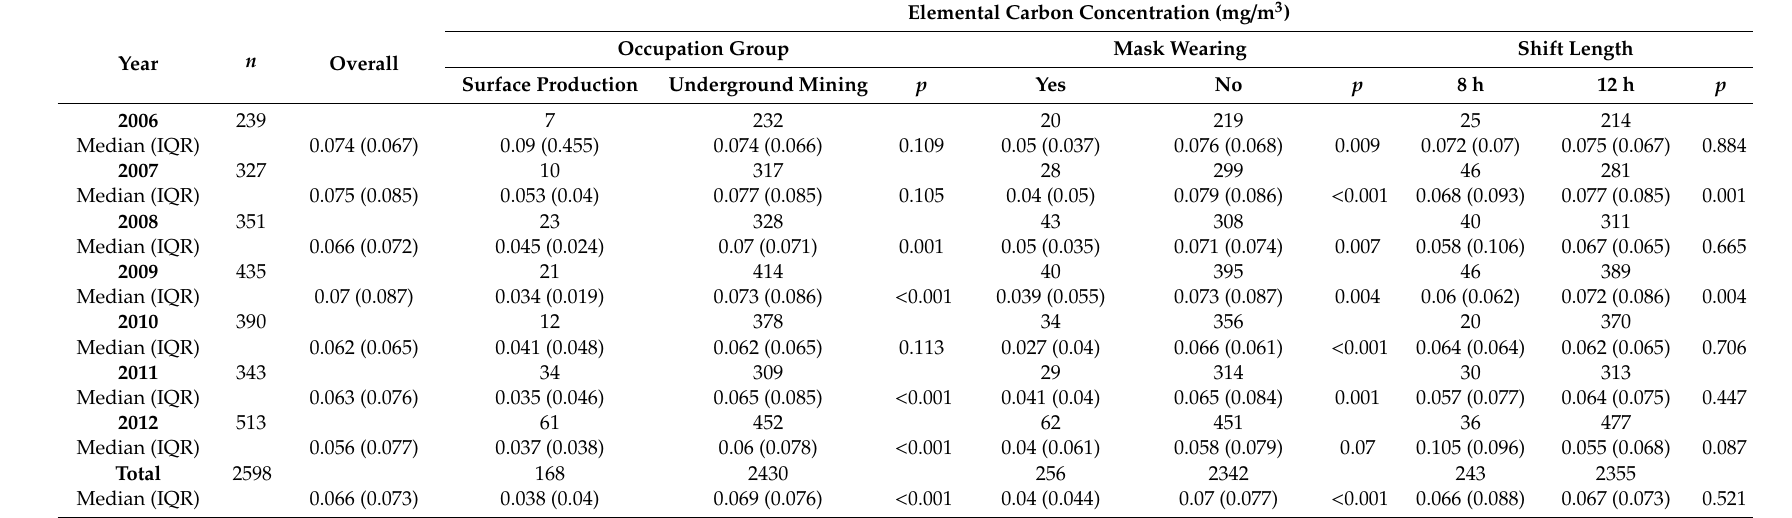
Table 2. Elemental carbon exposure of Western Australian miners by occupation group, mask wearing status, and work shift length,